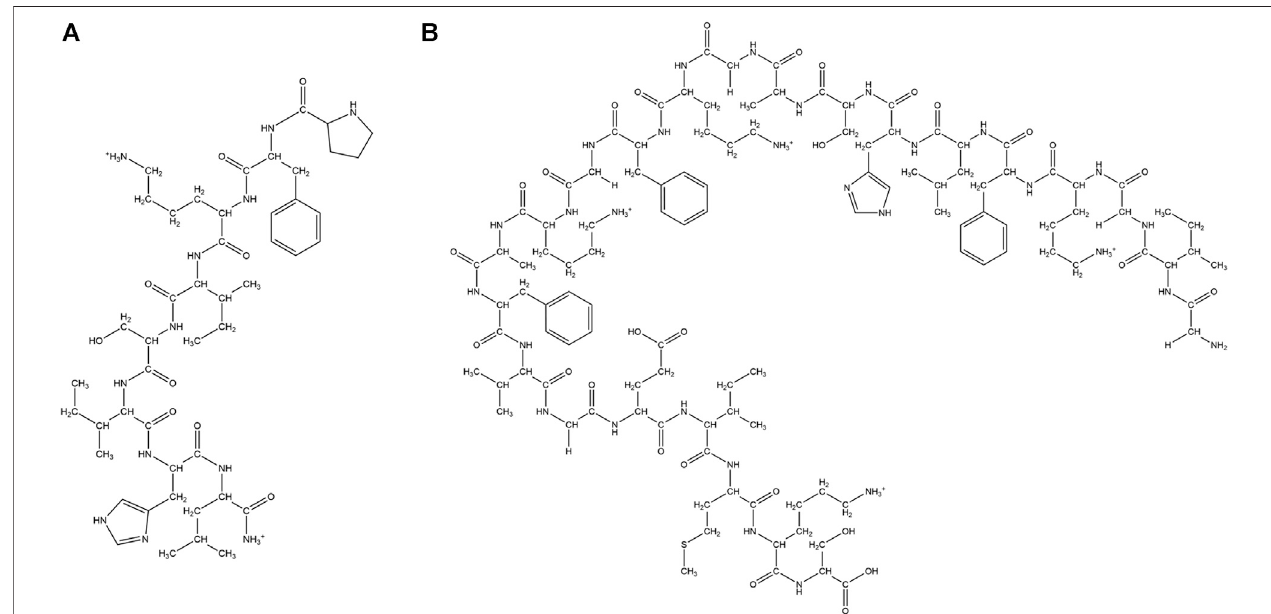
FIGURE 2 | Examples of natural cationic AMPs. (A) Jelleine − 1. (B)